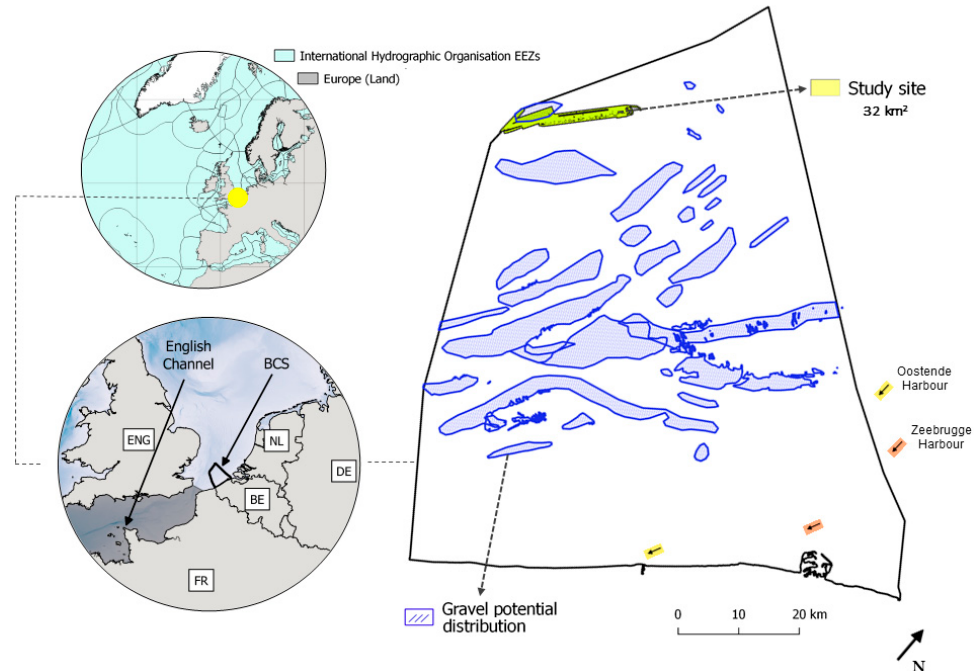
Figure 1. Geographical setting ( left ; circular maps) of the BCS ( right ; geographically tilted, see north arrow) displaying the gravel potential distribution map [39] and the surveyed study area. Universal Transverse Mercator Zone 31 North, World Geodetic System 84 (UTM 31N, WGS84).